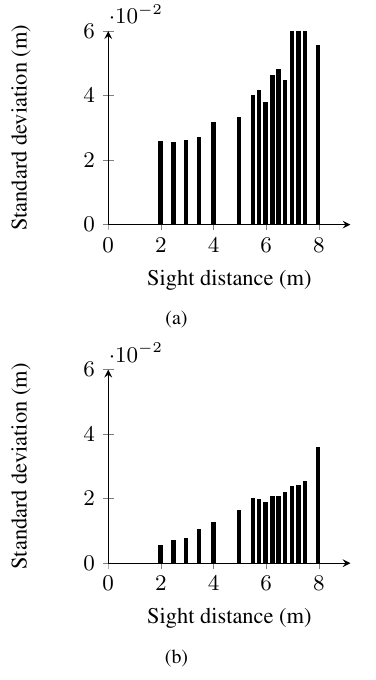
Figure 17. Sketch of the experimental outdoor set-up in dynamic